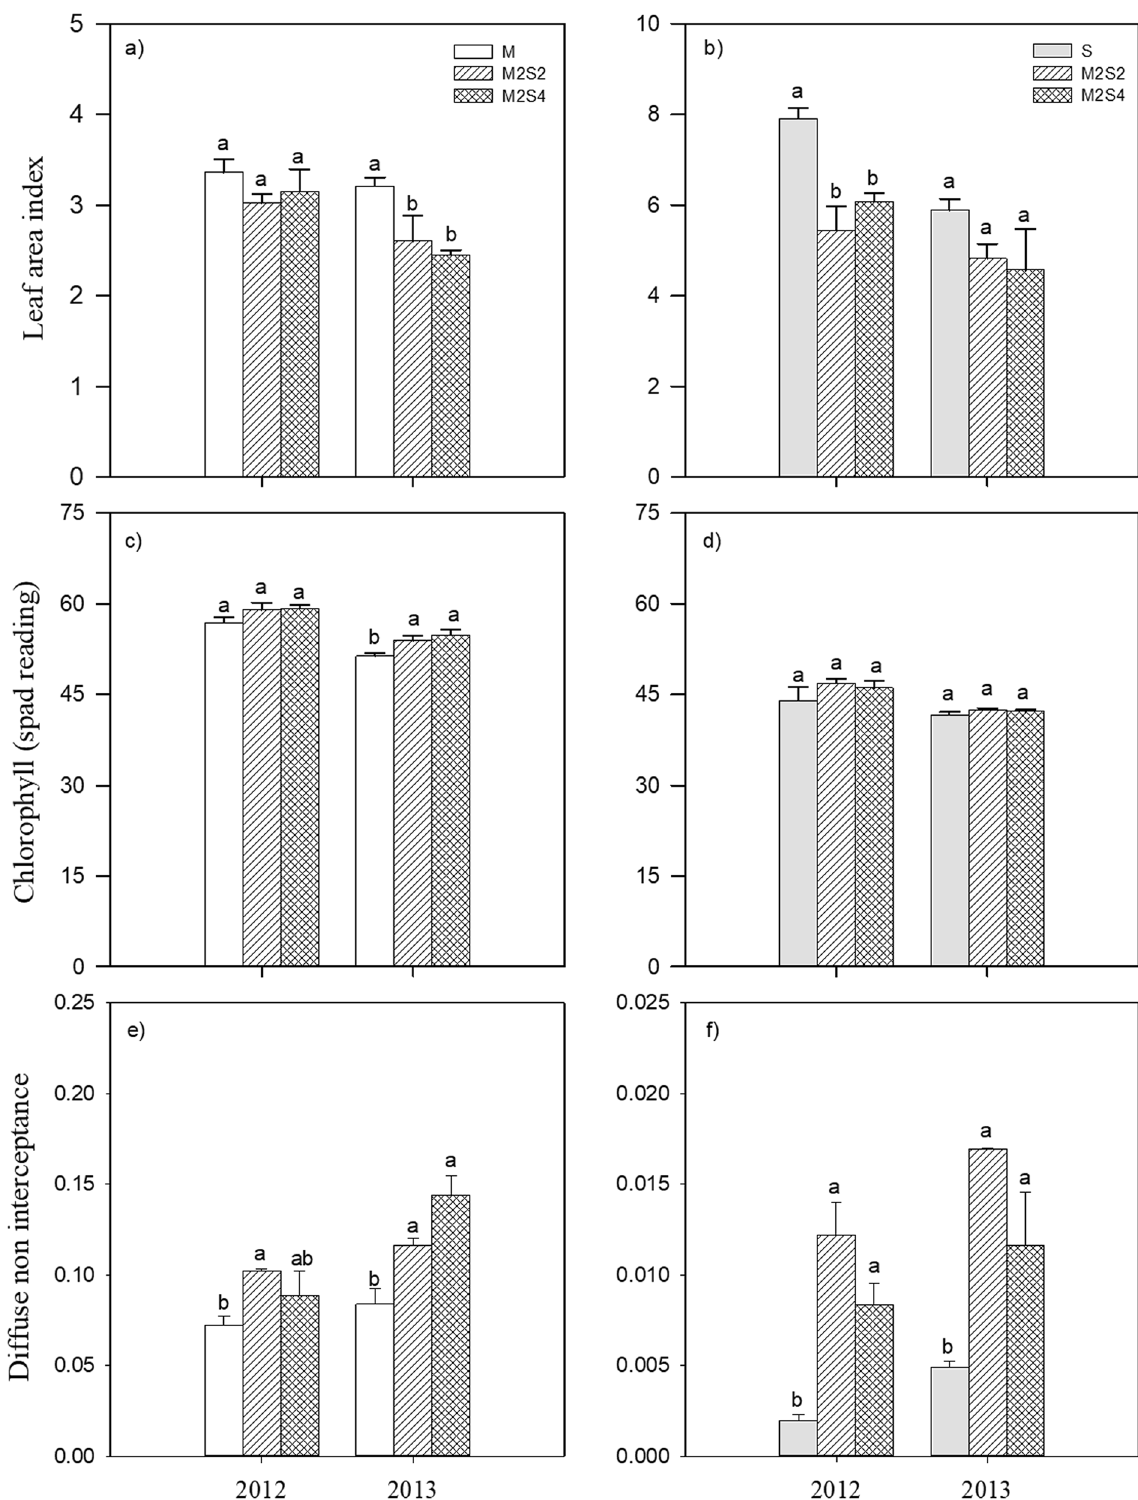
Figure 3. Leaf area index, chlorophyll (spad reading), diffuse non interceptance of maize ( a , c , e ) and soybean ( b , d , f ) grown under sole crop and intercrop systems in 2012 and 2013. Bars are means + standard errors. Bars with different letters are significantly different between cropping systems for each year ( P < 0.05). M, sole- cropped maize; S, sole-cropped soybean; M2S2, two rows of maize intercropped with two rows of soybean; M2S4, two rows of maize intercropped with four rows of